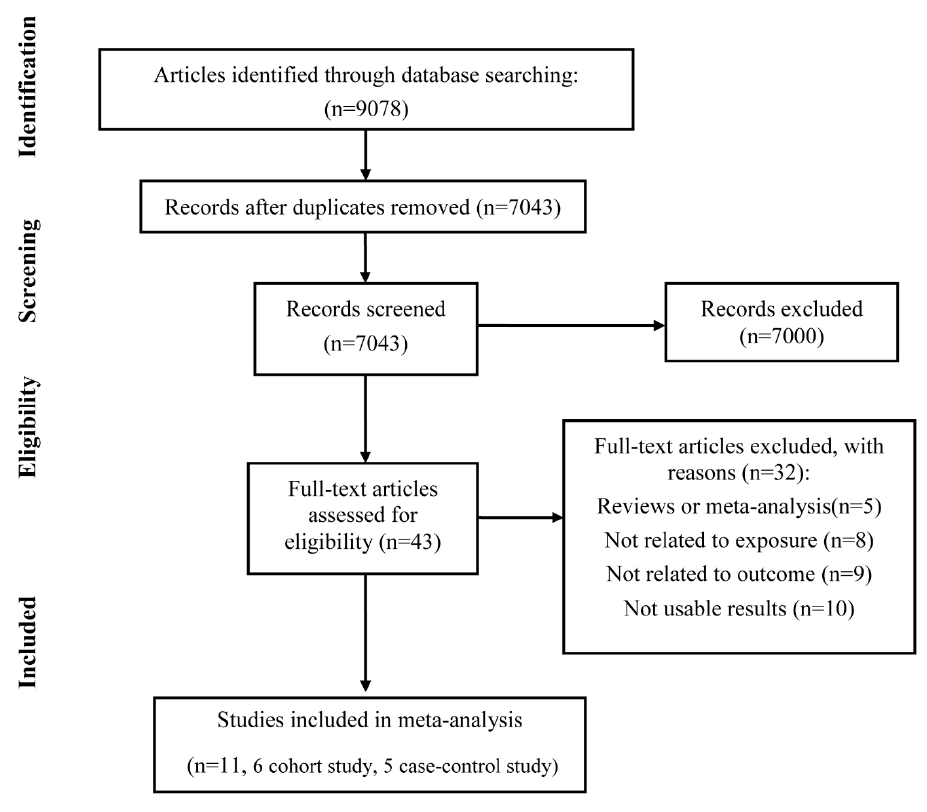
Figure 1. PRISMA flow diagram showing the detailed selection of eligible studies. Table 1. Characteristics of included studies.